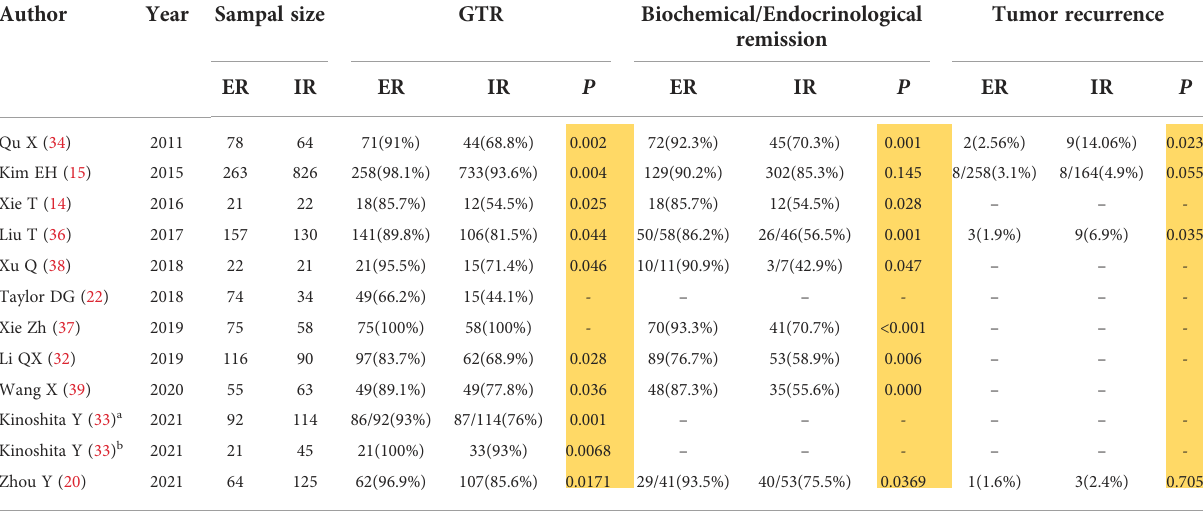
TABLE 1 ER and the rate of the GTR, Biochemical/Endocrinological remission, Tumor